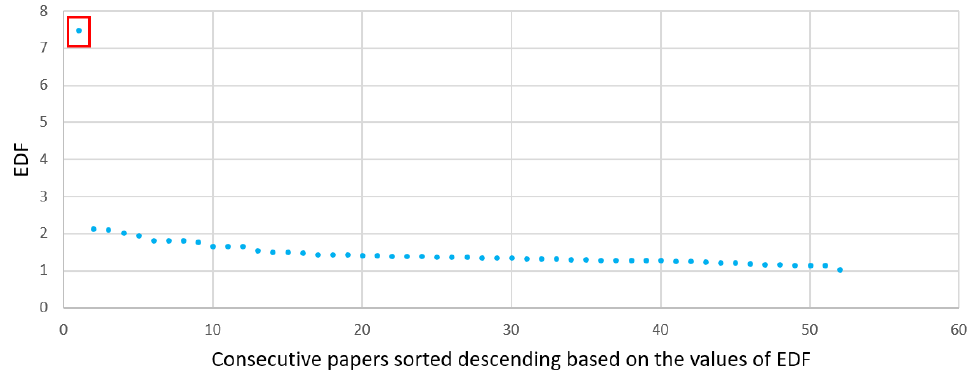
Figure 23. Variability of EDF in reviewed papers, with red-marked less credible value.